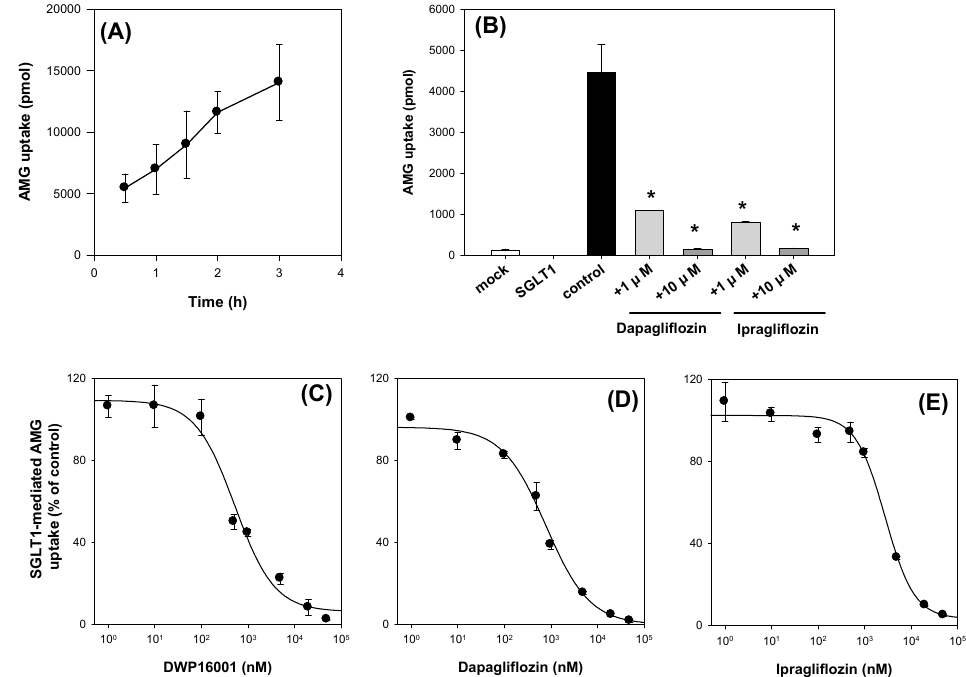
Figure 7. ( A ) Uptake of 10 µM [ 14 C]methyl-a-D-glucopyranoside (AMG) was measured in CHO- sodium-glucose cotransporter 1 (SGLT1) cells with a various incubation time (0.5–3 h). ( B ) Inhibitory effect of dapagliflozin and ipragliflozin (1, 10 µM) on the uptake of 10 µM [ 14 C]AMG in CHO-mock and -SGLT1 cells was measured for 2 h. Concentration dependent inhibition of DWP16001 ( C ), dapagliflozin ( D ), and ipragliflozin ( E ) on the SGLT1-mediated uptake of [ 14 C]AMG. SGLT1-mediated uptake of [ 14 C]AMG was calculated by subtracting the uptake of 10 µM [ 14 C]AMG for 2 h in CHO-mock cells from that in CHO-SGLT1 cells in a concentration range of 1–50,000 nM of DWP16001, dapagliflozin, and ipragliflozin. Each data point represents the mean ± standard